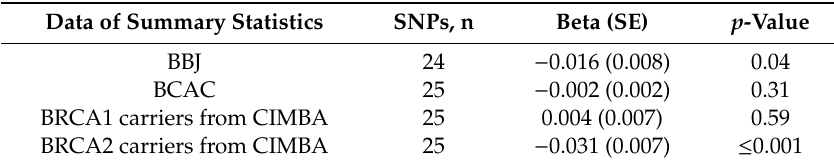
Table 2. MR Egger regression for estimating average pleiotropic e ff ect across the genetic variants in the causal inference of rheumatoid arthritis as a risk factor on the risk of breast cancer in two-sample Mendelian